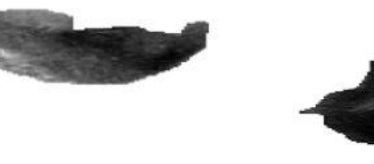
Figure 6. Original Ultrasound scanning Image.